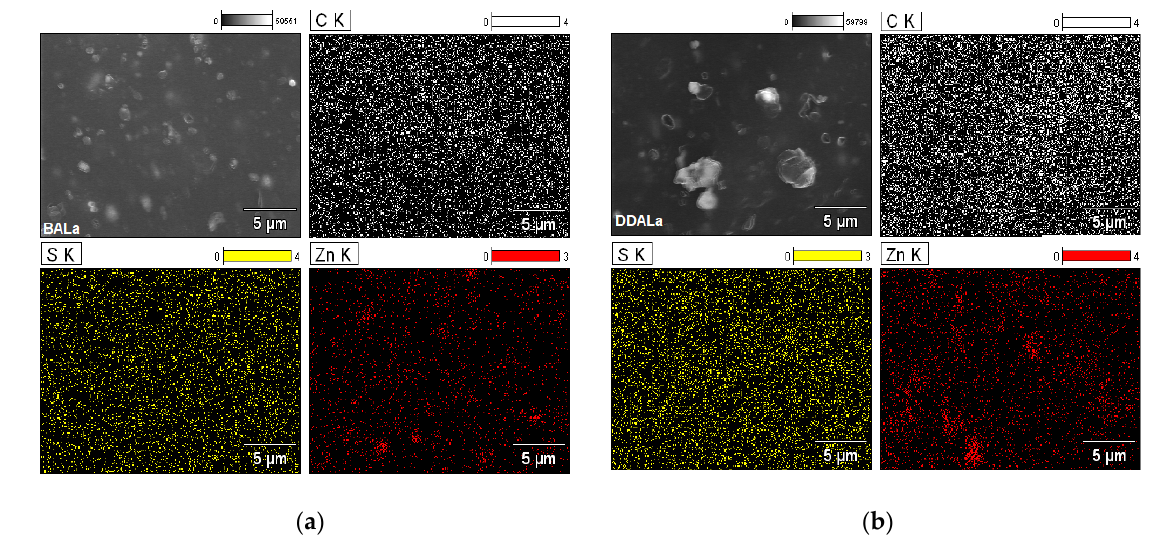
Figure 22. EDS maps for EPDM vulcanizate containing: ( a ) BALa; ( b ) DDALa.